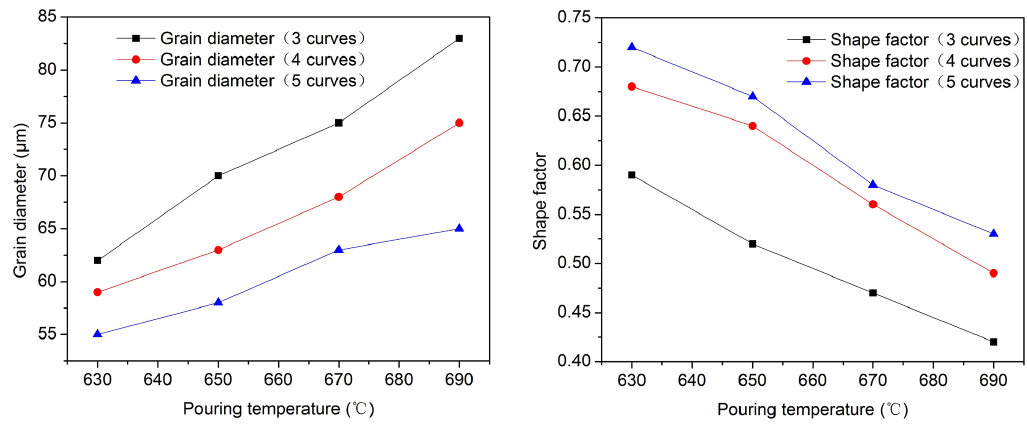
Fig. 7 Effects of curve number on D and S